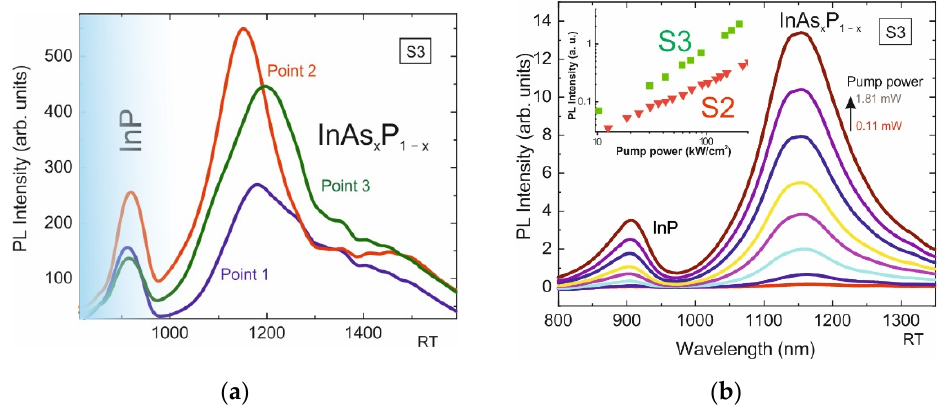
Figure 7. ( a )—PL spectra of sample S3 obtained at points 1–3 at a pump power density of 127 kW/cm 2 . ( b )—PL spectra from single InP/InAs x P 1 − x /InP nanoinsertion in sample S3 obtained at different optical pump powers (0.11 mW(14kW/cm 2 )–1.81mW(230kW/cm 2 ); inset: Pl intensity of the samples S2 and S3 versus optical pump power.